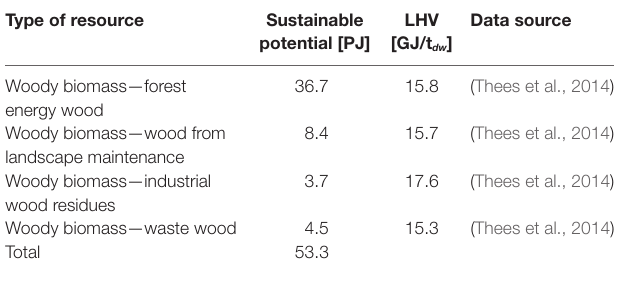
TaBle 7 | Annual woody biomass sustainable potential (today